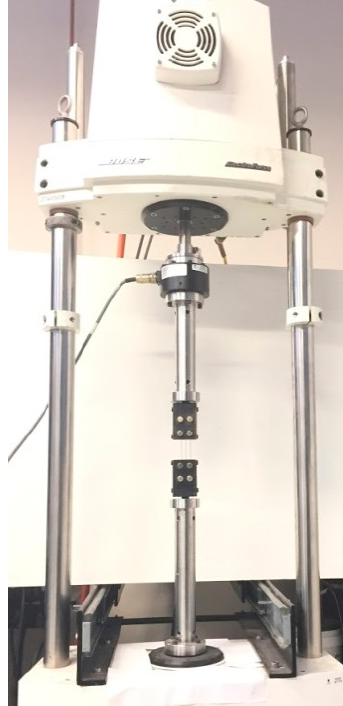
Figure 7. The experimental setup for tensile test on a Bone Bandaid NiTi wire.